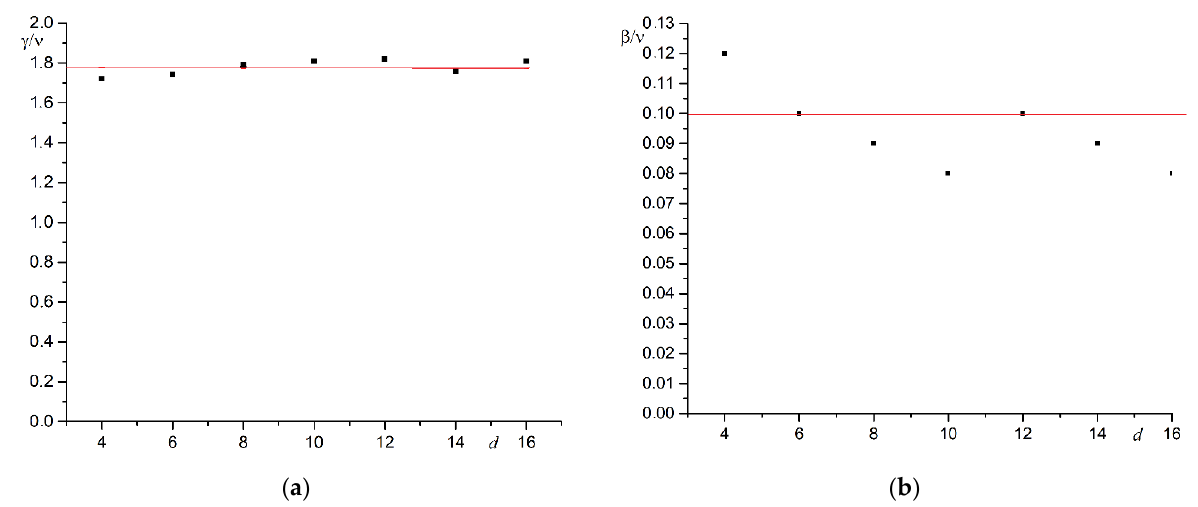
Figure 3. Relationship of critical exponents ( a ) γ / ν and ( b ) β / ν to antidote lattice period d with hole size a = d /2. A red line is a critical exponent for a continuous film. Points denote critical exponents for different periods of the antidote lattice. A red line is a critical exponent for a solid film.